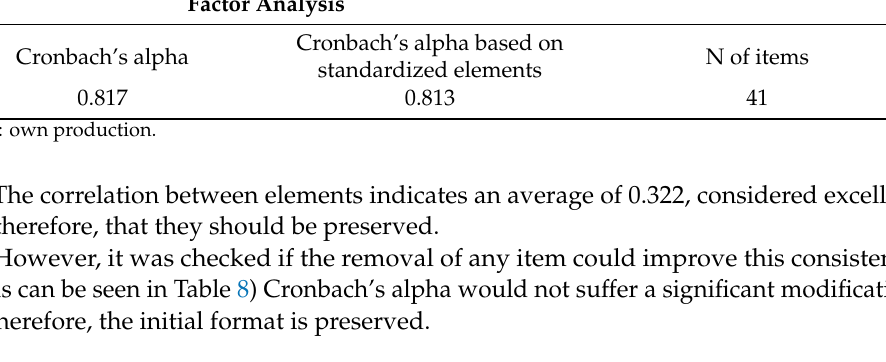
Table 7. Cronbach’s alpha calculation of the fourth dimension. Factor Analysis